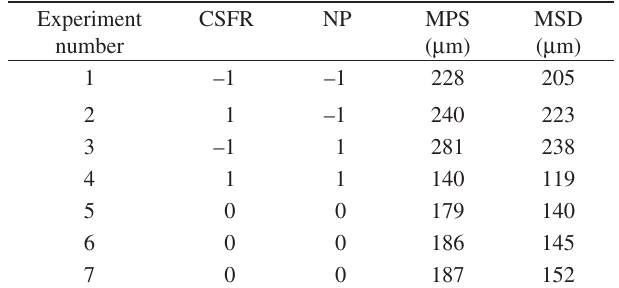
Figure 4. a) Response surface, showing the effects of chitosan solution flow rate (CSFR) (mL/min) and nitrogen pressure (NP) (kgf.cm –2 ) on microsphere diameter ( µ m); and b) Response surface, showing the effects of chitosan solution flow rate (CSFR) (mL/min) and nitrogen pressure (NP) (kgf.cm –2 ) on standard deviation ( µ Table 4. Treatment schemes for a two-factor design of experiments and re- sponses: mean particle size (MPS) and mean standard deviation (MSD).